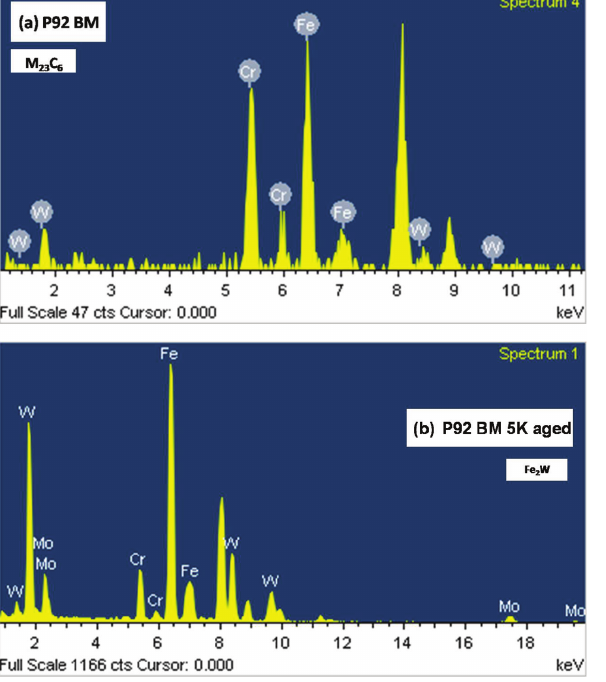
Figure 4: EDS spectra obtained from the (a) M 23 C 6 precipitates in the normalized and tempered steel, and (b) Laves phase (Fe 2 W) preci- pitates in the thermal aged at 923 K for 5000 h steel.